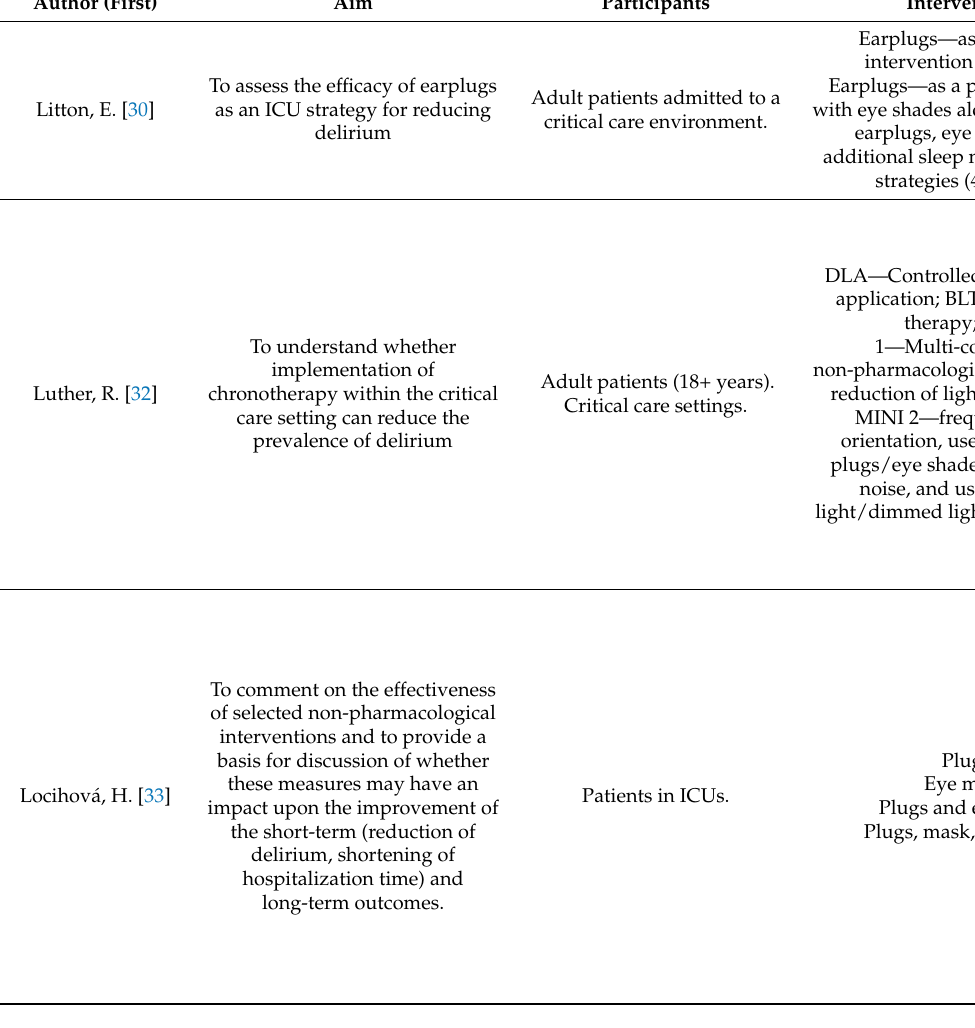
Table 4. Tabular presentation of qualitative findings of the umbrella